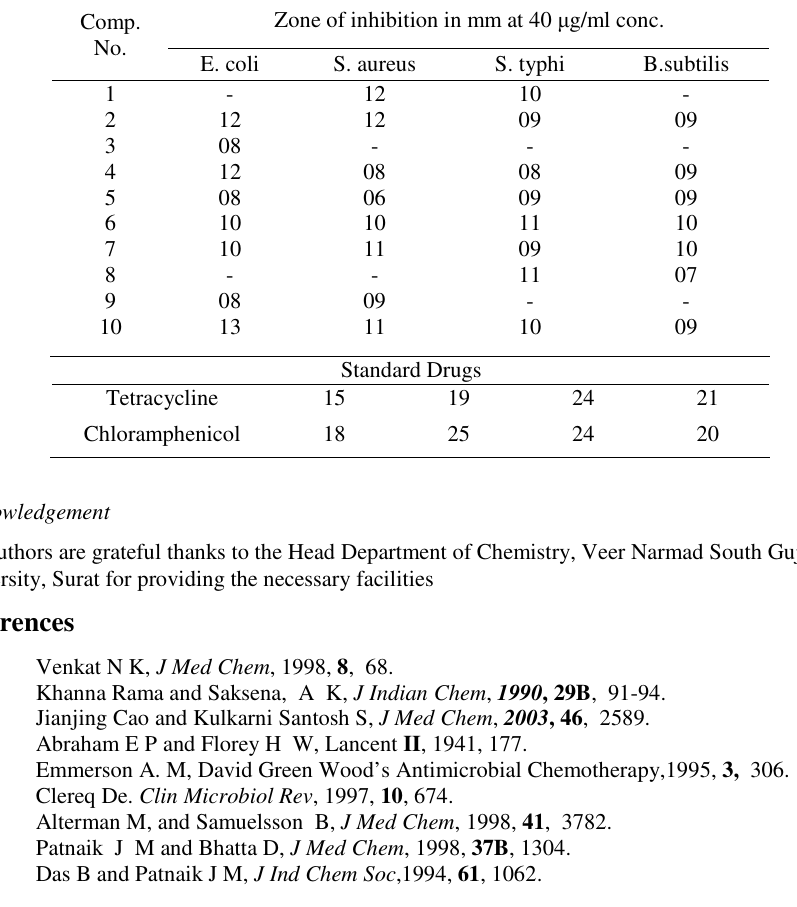
Table-3 . Antibacterial activity of newly synthesized compounds